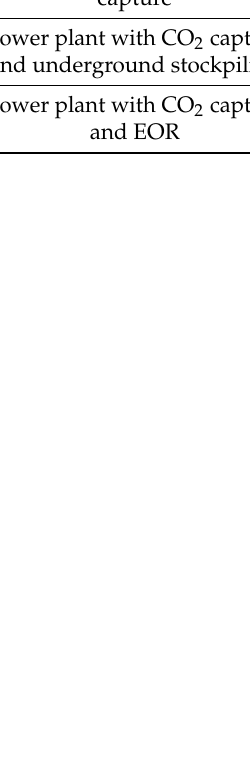
Table 3. Comparison of cost for different capture technologies for coal-fired power plants (Source: